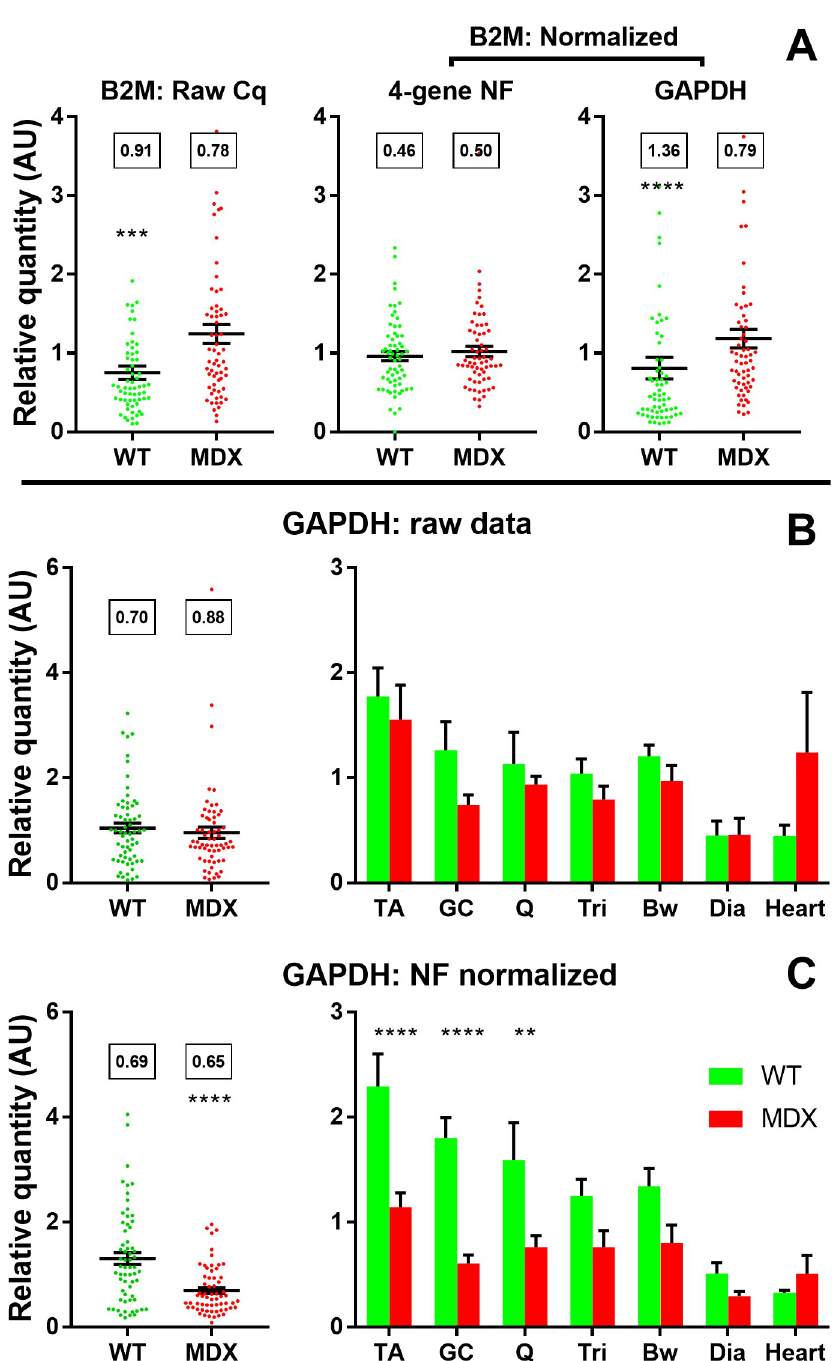
Fig 6. Beta 2 microglobulin and Glyceraldehyde 3-phosphate dehydrogenase expression. (A) Expression data for B2M in all healthy and dystrophic samples, either raw relative quantity (RQ) values (left); normalized to the geometric mean of ACTB , RPL13a , CSNK2A2 and AP3D1 (centre); or to GAPDH (right). (B) and (C) Expression data for GAPDH in all healthy and dystrophic samples (left), or healthy and dystrophic samples sorted by muscle group (as indicated, right), either raw (B) or normalized to the geometric mean of ACTB , RPL13a , CSNK2A2 and AP3D1 (C) . All data shown either as means +/- SEM plus individual sample RQ values (•) or as means + SEM alone. �� :P < 0.01, ��� : P < 0.001, ���� :P < 0.0001 (Mann-Whitney U test (healthy/dystrophic) or one-way ANOVA with Sidak’s multiple comparisons test (healthy/dystrophic by muscle)). Boxes: Coefficient of Variation.